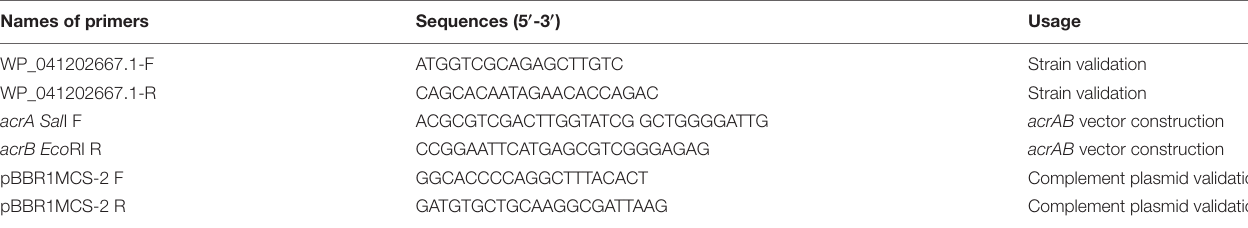
TABLE 2 | Primers used in this